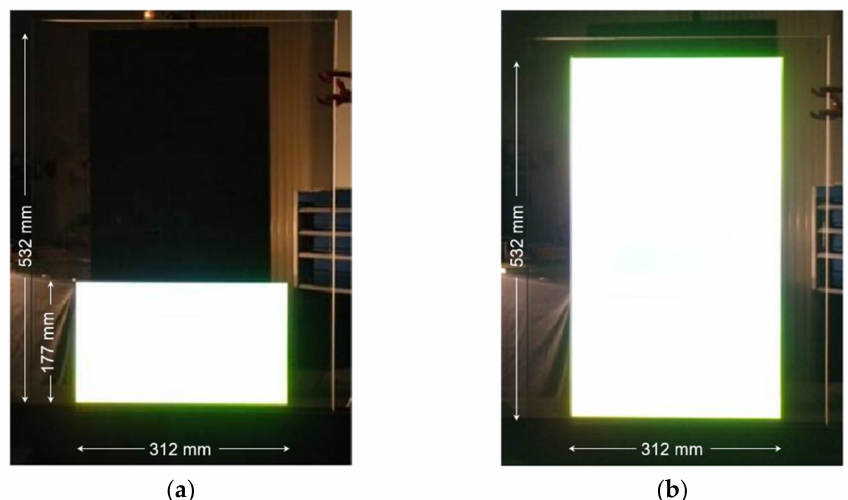
Figure 5. The view into the partially ( a ) and consecutive ( b ) recorded P-HOEs from the position of the focal position of the real image of the diffusor (phase conjugated reconstruction). The fill factor was ∼ 0.217 for the partial